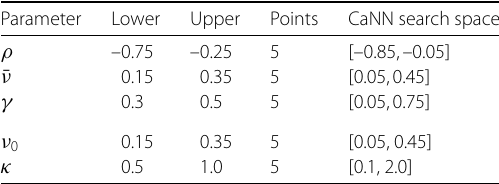
Table 6 Uniformly distributed points between the lower and upper bounds of the Heston parameters